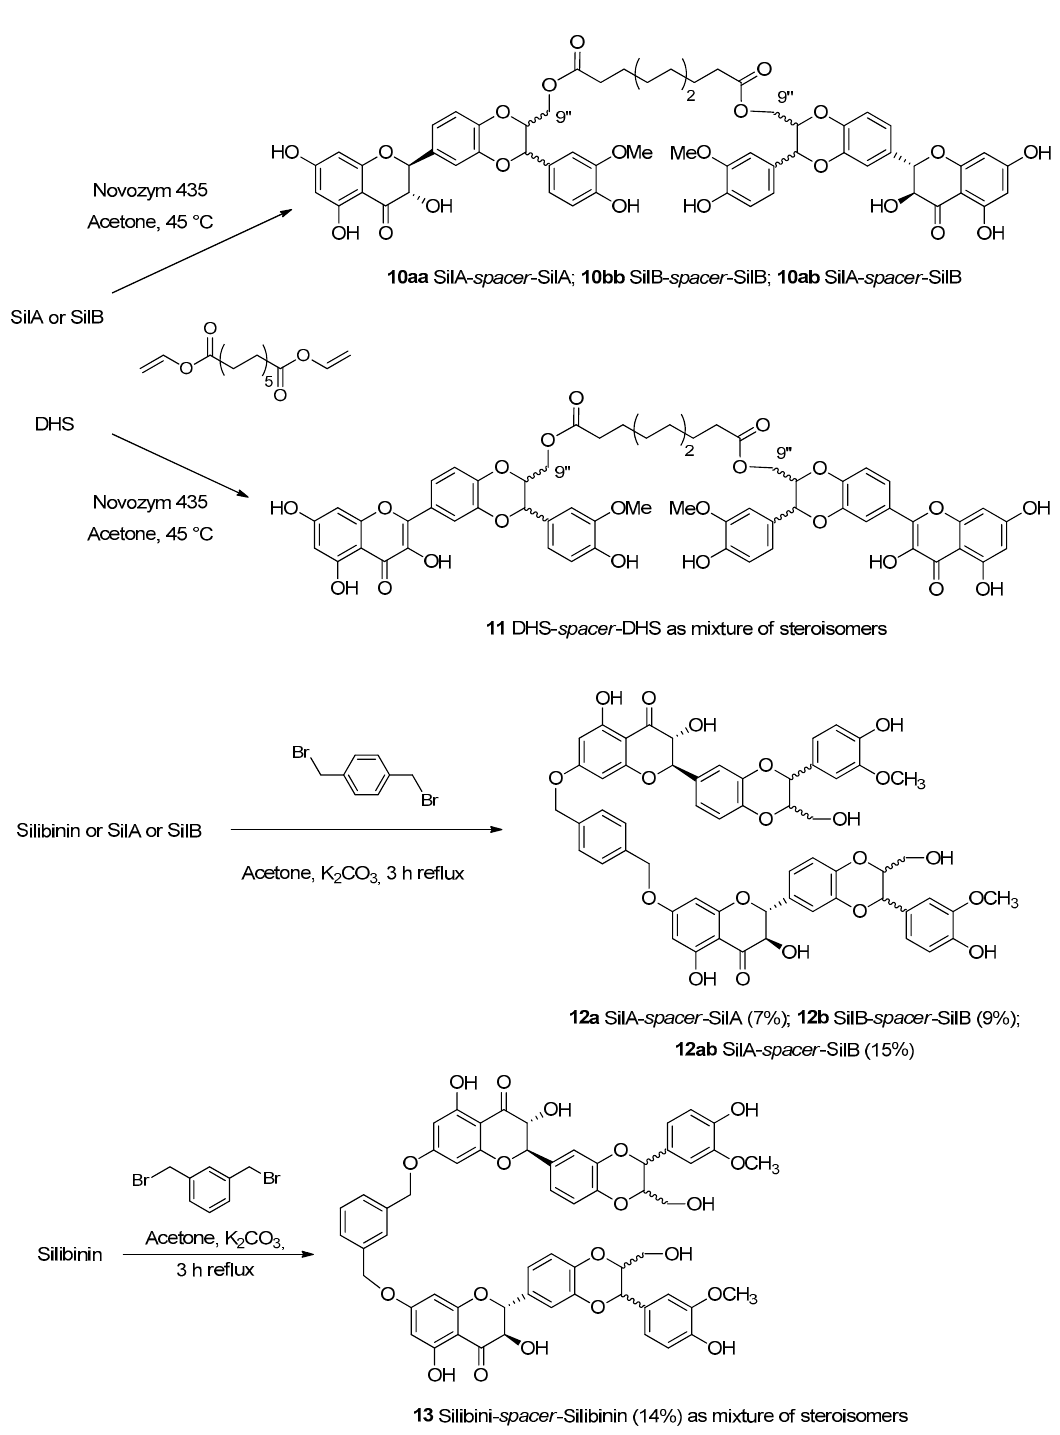
Figure 6. Lipase-catalyzed synthesis of silybin and dehydro-silybin (DHS) dimers ( 10 – 11 ) and synthesis of silibinin dimers with ether spacer ( 12 – 13 ).